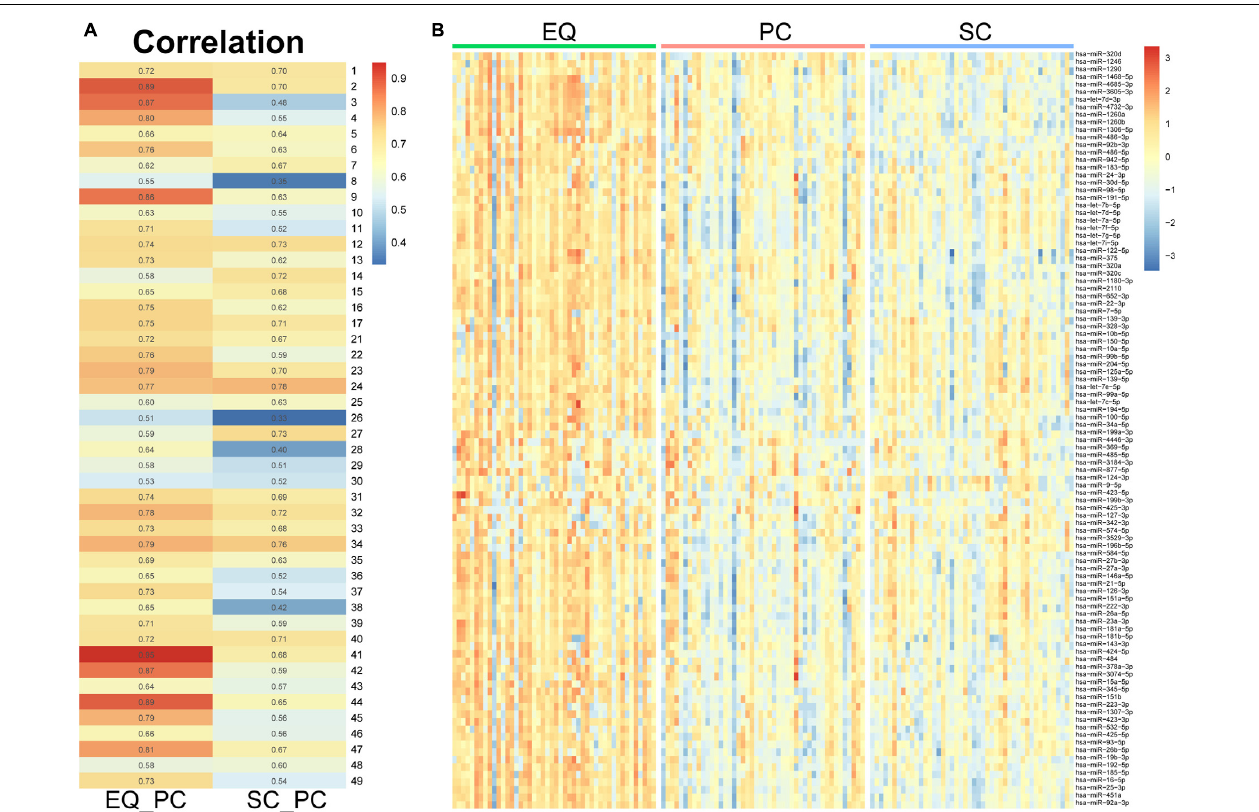
FIGURE 7 | miRNA expression under three isolation methods. (A) Spearman correlation coefficient was calculated from miRNA expression data in the pair of EQ-PC and SC-PC in each sample. EQ data exhibited higher correlation with PC data than SC with PC. (B) Heatmap of miRNA expression in 46 samples. The top 100 abundant miRNAs were displayed. Higher expression levels were obviously observed in EQ